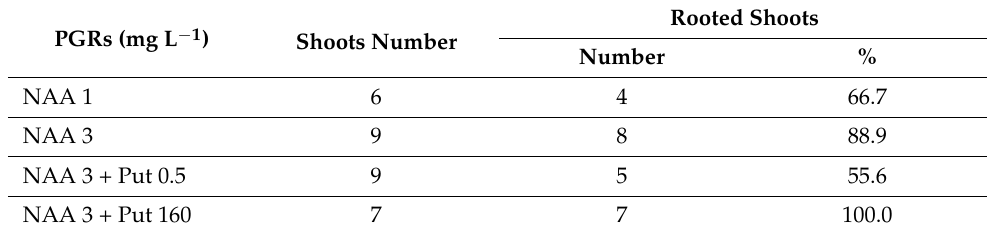
Table 7. Shoot rooting of red beet “Czerwona Kula” depending on PGR composition. Rooting medium contained 1 / 2 MS mineral salts and 20 g L − 1 sucrose.